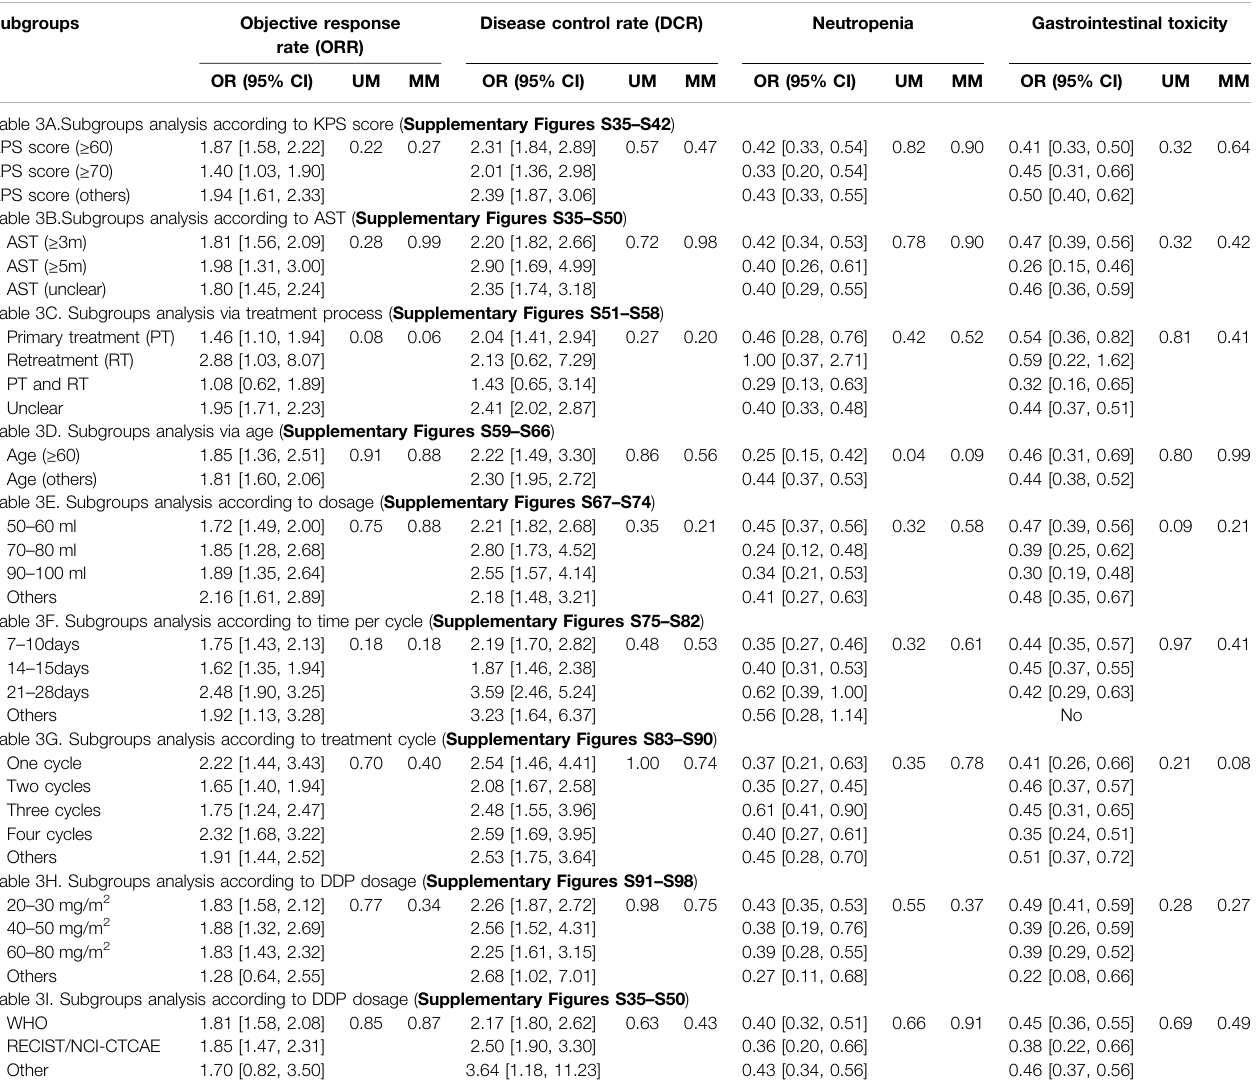
TABLE 3 | Subgroup and meta-regression analysis.